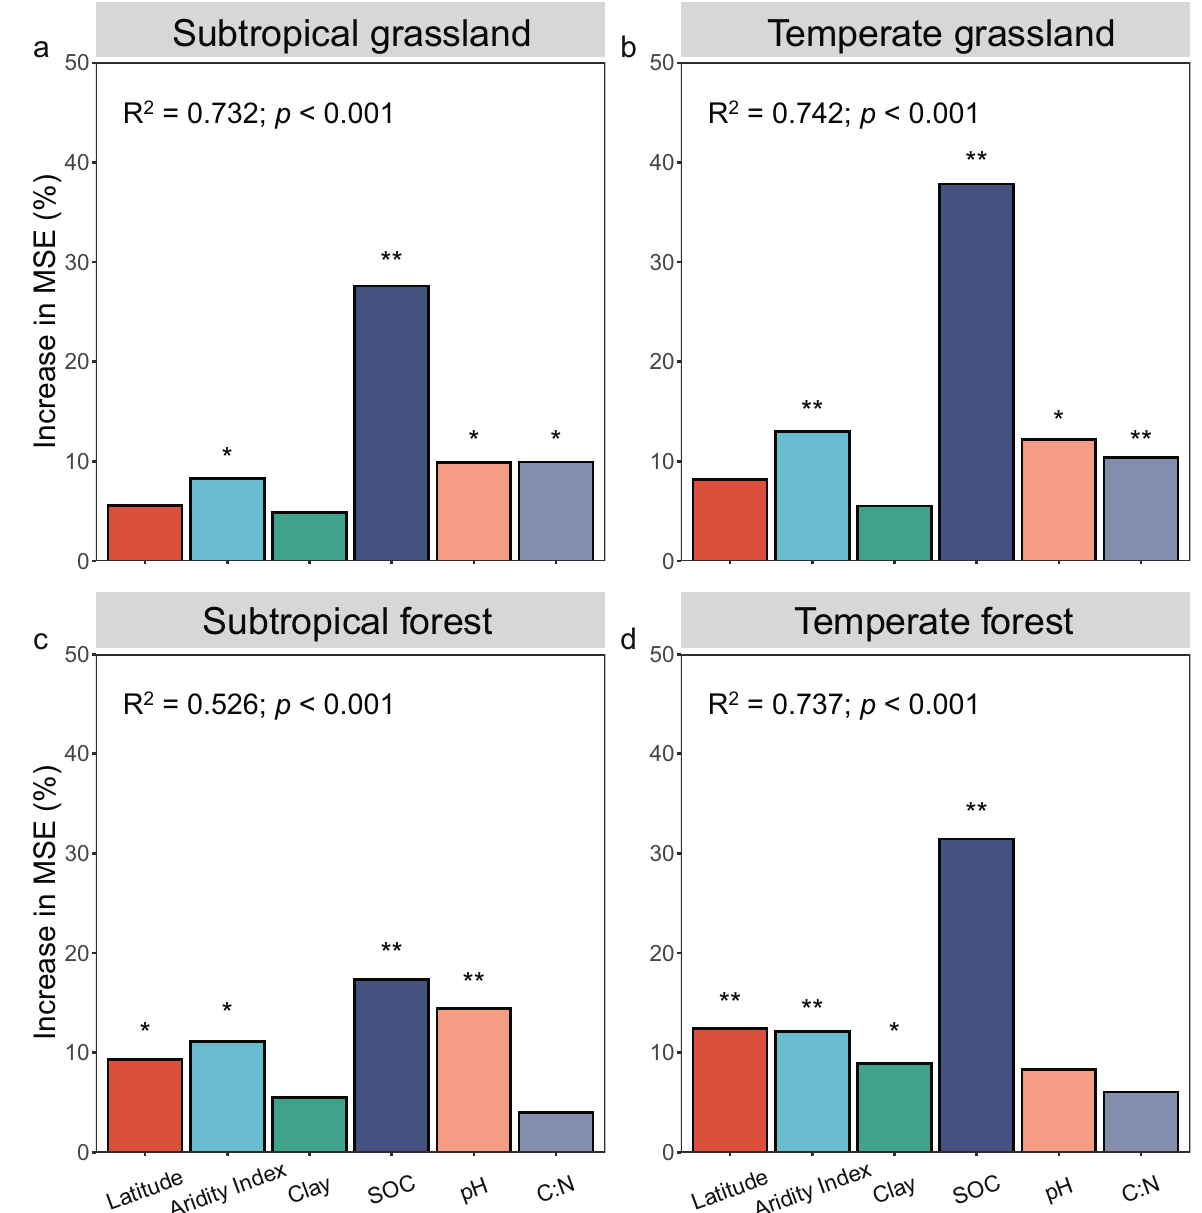
Fig. 5 Random Forest models of different ecosystems and climatic zones. a Subtropical grassland. b Temperate grassland. c Subtropical forest. d Temperate forest. Random Forest models showing the average predictive importance (mean square error (MSE) increase percentage) of each environmental factor in the absolute content of soil amino sugars (characterization of microbial residues). Asterisks indicate the signi fi cance of each predictor, with one and two asterisks indicating p < 0.05 and p < 0.01, positive regulatory factor for amino sugars (Fig. 7). In grasslands, aridity index and soil pH were the next most important predictors (Fig. 7a, b), while the absolute latitude strongly predicted amino sugars in temperate grasslands (STE: 0.280, Fig. 7b). In subtropical forests, the effect of soil pH on amino sugars was second only to that of SOC, followed by soil C : N ratio and soil clay content (Fig. 7c). The soil C : N ratio in temperate forests showed a strong negative effect on amino sugars (STE: − 0.272, Fig. 7d).